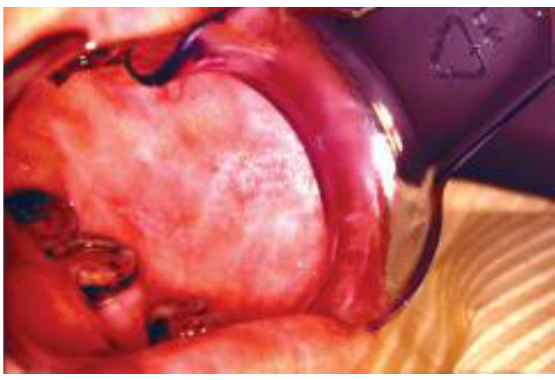
Figure 8. Lesions caused by using betel